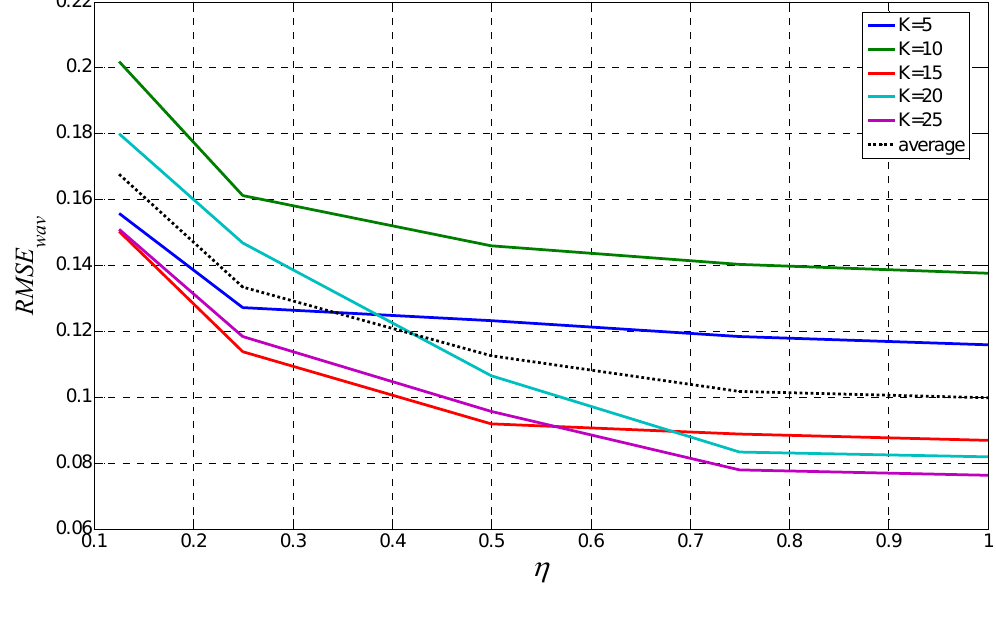
for the wavy text wav